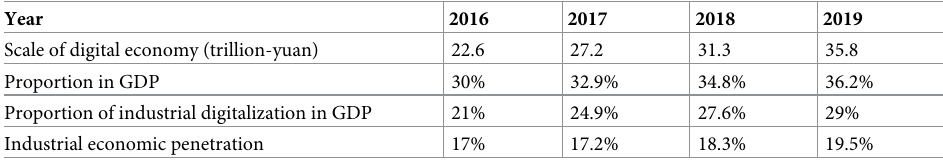
Table 1. Digital development of China’s manufacturing